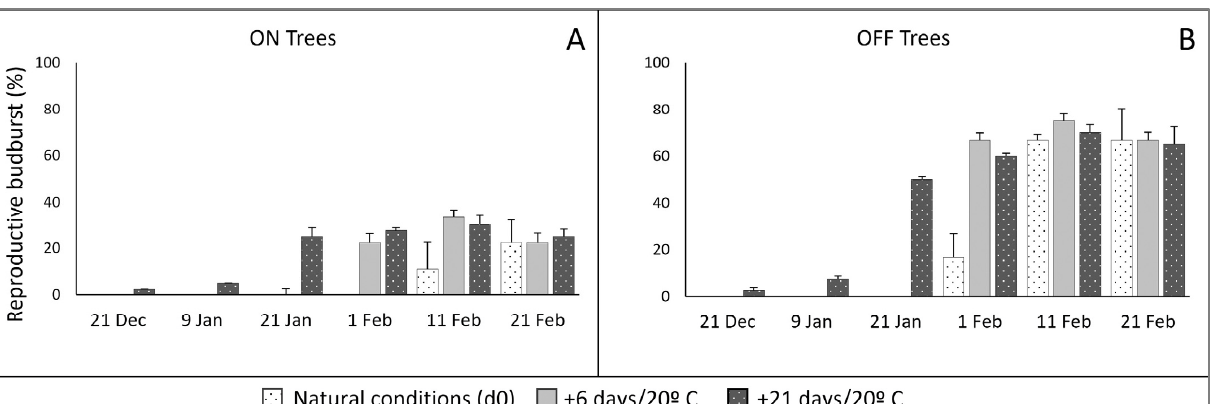
Figure 3. Reproductive budburst percentage from bearing (ON; ( A )) and nonbearing (OFF; ( B )) trees sampled at different dates during natural chilling accumulation and observed following three procedures: at the time of sampling (d0), and after growth chamber forcing of cuttings at 20 °C for 6 days (d + 6/20 °C) and 21 days (d + 21/20 °C). Data combine microscope observation of reproductive differentiation and visual observation of phenological stage. Vertical bars = standard error.